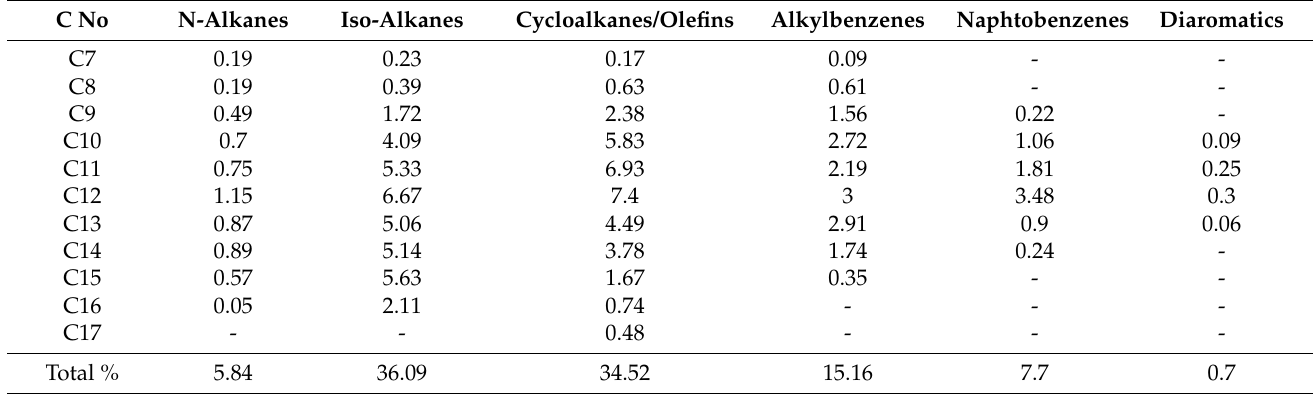
Table 1. Molar fractions of kerosene fuel [33]. Reprinted with permission from ref. [33]. Copyright 5164861069604